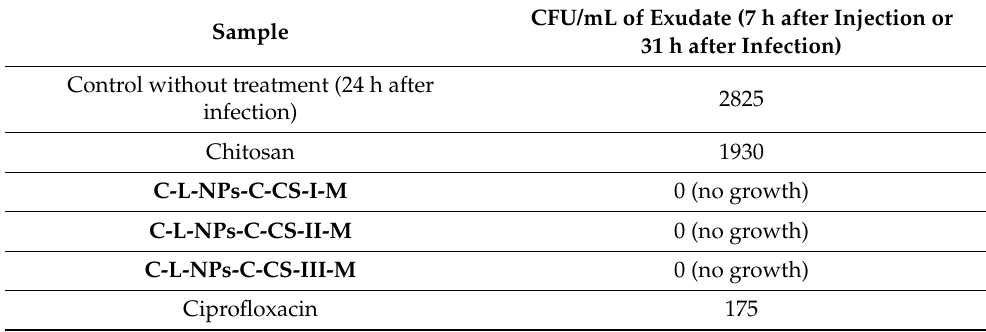
Table 11. In vivo antibacterial activity of the loaded self-assembled nanoparticles based on ciprofloxacin-chitosan conjugates without the spacer (Scheme 1, system 3; Table 7) in comparison with the starting chitosan and